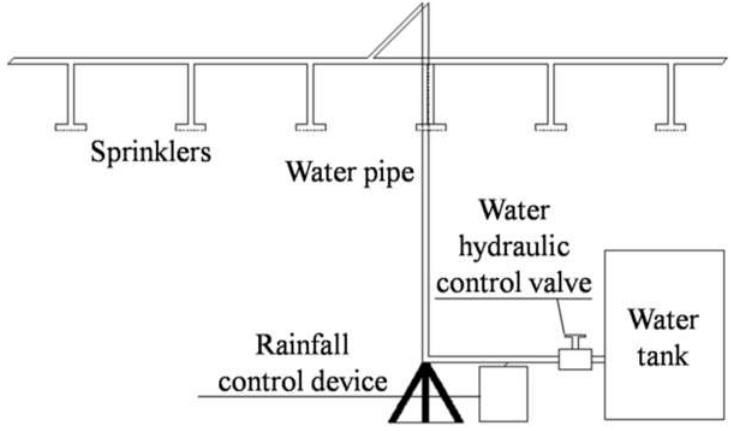
Figure 5. Sketch of the rainfall system.